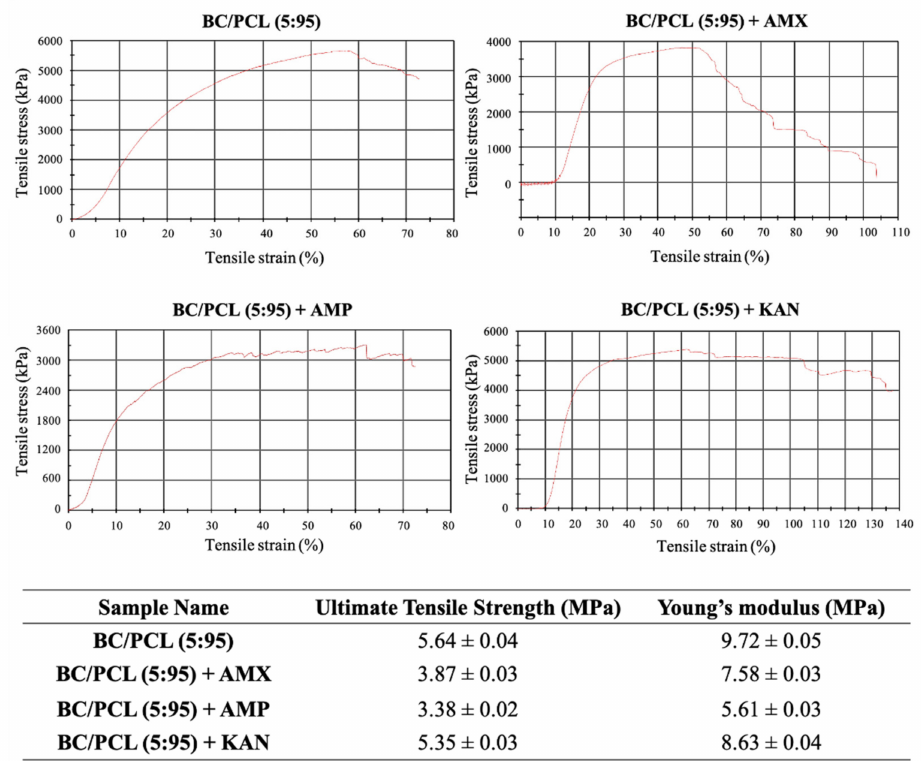
Figure 5. Stress-strain curves of EHD-3D printed patches with ultimate tensile strength and Young’s modulus